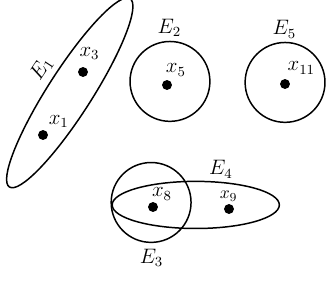
Figure 8. The ( 0.5,0.5,0.6 ) -level hypergraph of H